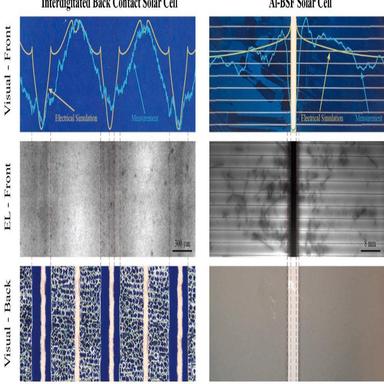
Examples of artefacts in EL images which cannot be explained only with underlying electrics; a) Visible rear pattern of an otherwise homogeneous IBC solar cell, and b) Visible rear Ag metallization strip of an Al BSF solar cell.